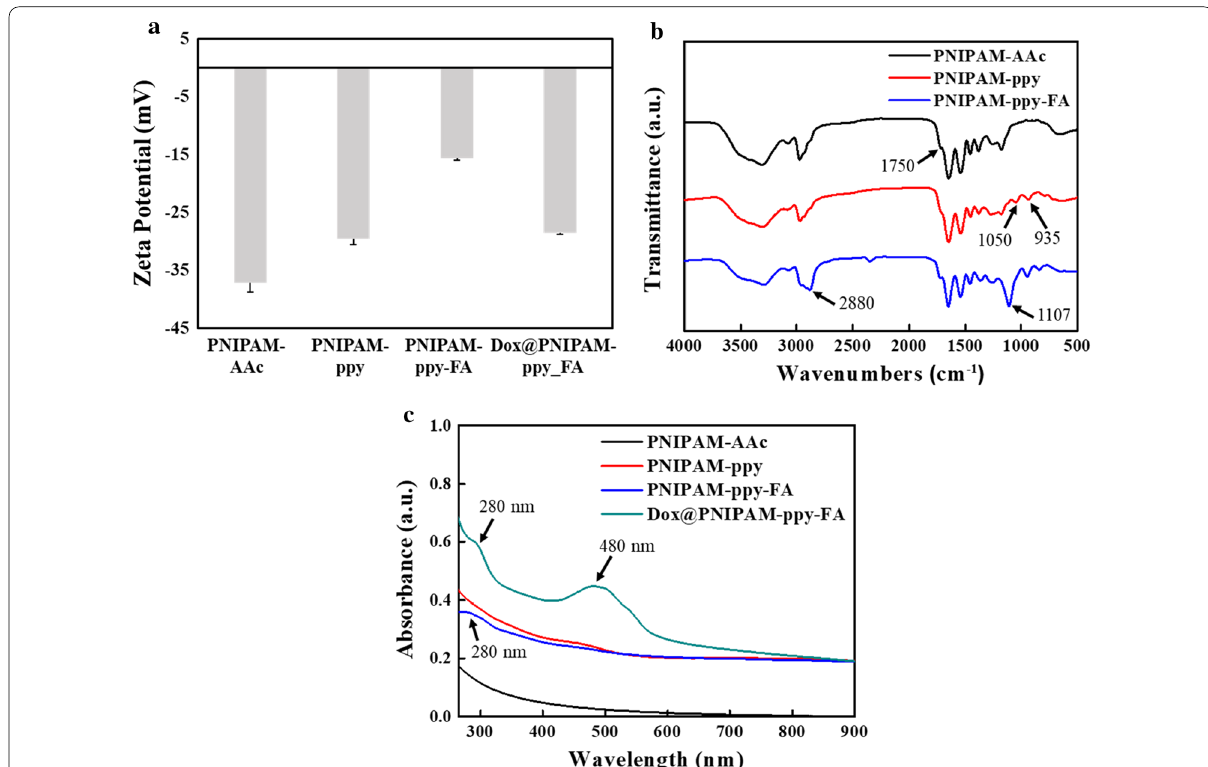
Fig. 2 a Zeta potential analysis of PNIPAM-AAc, PNIPAM-ppy, PNIPAM-ppy-FA, and Dox@PNIPAM-ppy-FA. b FT-IR spectra of PNIPAM-AAc, PNIPAM-ppy, and PNIPAM-ppy-FA. c UV–Vis spectra of PNIPAM-AAc, PNIPAM-ppy, PNIPAM-ppy-FA, and